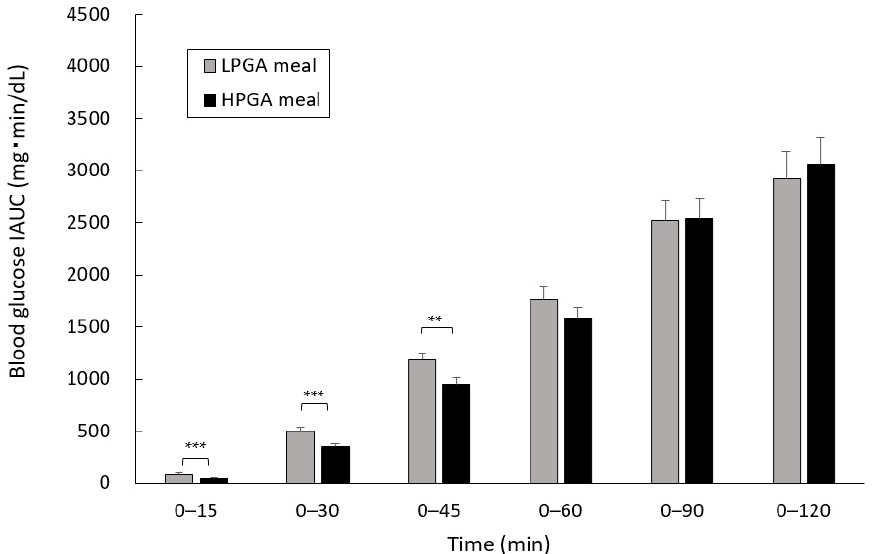
Figure 2. Effects of LPGA and HPGA meals on the levels of blood glucose IAUC. Liner mixed model analysis was used to compare the blood glucose IAUC at each time point, with the test meals (LPGA and HPGA meals) and groups as fixed effects. These data are presented as the est. mean ± SE. ** p < 0.01, *** p < 0.001. LPGA: low-gamma-polyglutamic acid; HPGA: high-gamma-polyglutamic acid; IAUC: incremental area under the curve.